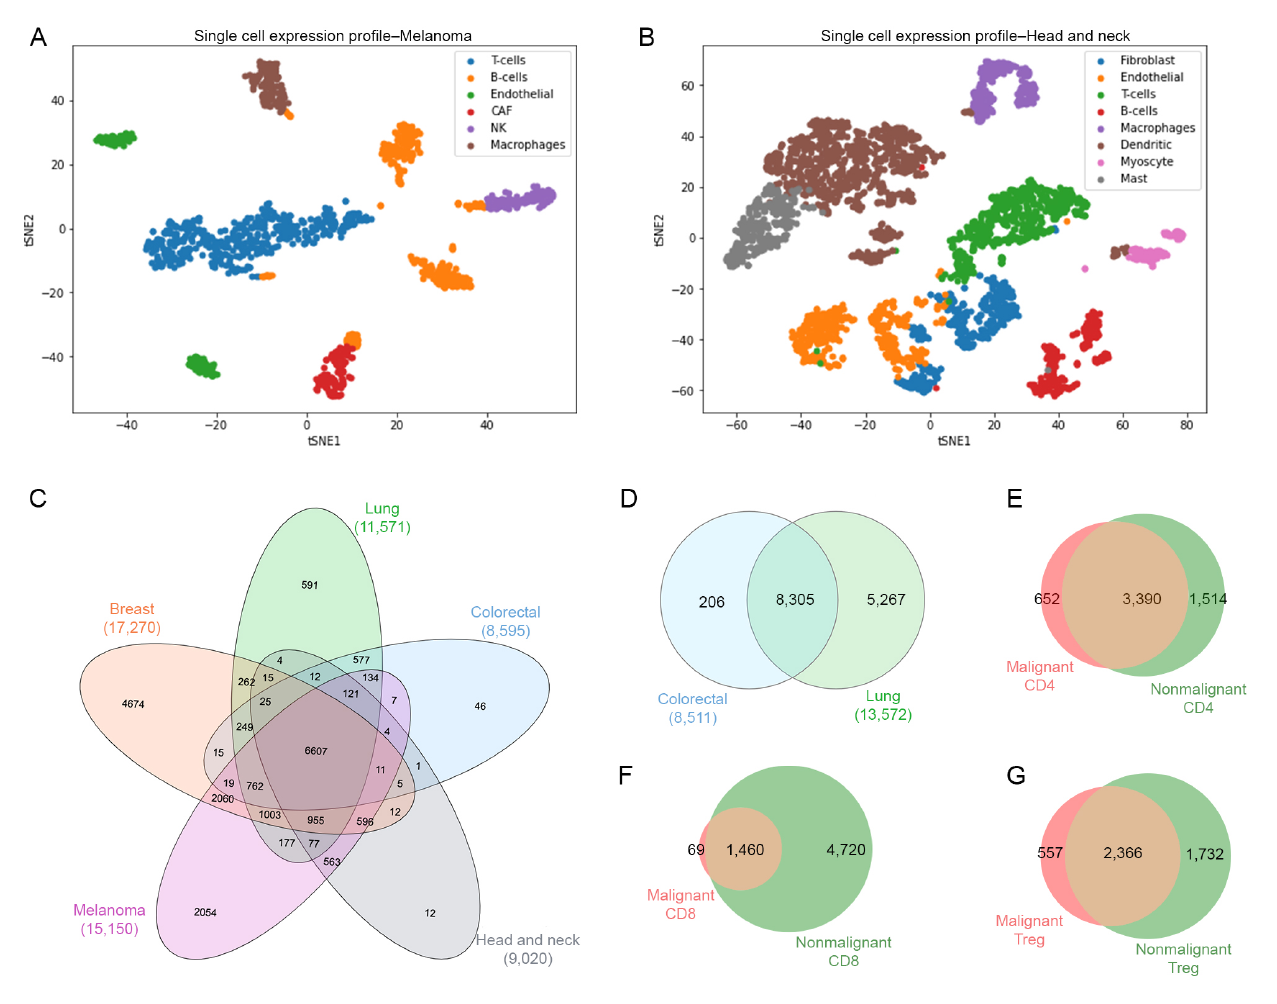
Figure 2. Cell identification. ( A ) Single cells plot of gene expression profiles using dimensionality reduction technique t-SNE for malignant cells for melanoma cancer data colored by type of cells such as T, B, macrophages, endothelial, CAF (cancer associated fibroblasts) and natural killer cells. ( B ) Malignant cells for head and neck cancer data colored by type of cells such as T, B/plasma, macrophages, dendritic, mast, endothelial, fibroblast, myocytes cells. ( C ) Venn diagram of number of genes of T-cells across different types of cancer. ( D ) Venn diagram of number of genes of T-cells from nonmalignant samples. Venn diagrams for ( E ) CD4-T cells, ( F ) CD8-T cells, and ( G ) Treg cells representing the exclusive and common genes between malignant and nonmalignant